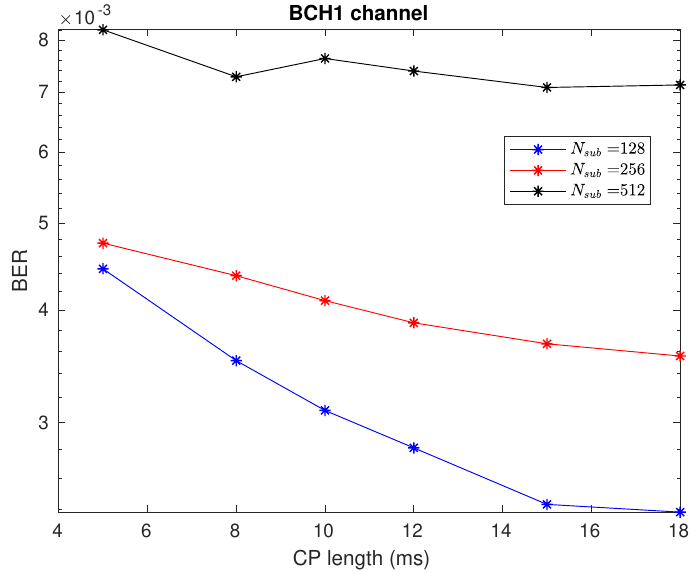
Figure 11. Results for BCH1 channel considering the genie − aided approach.